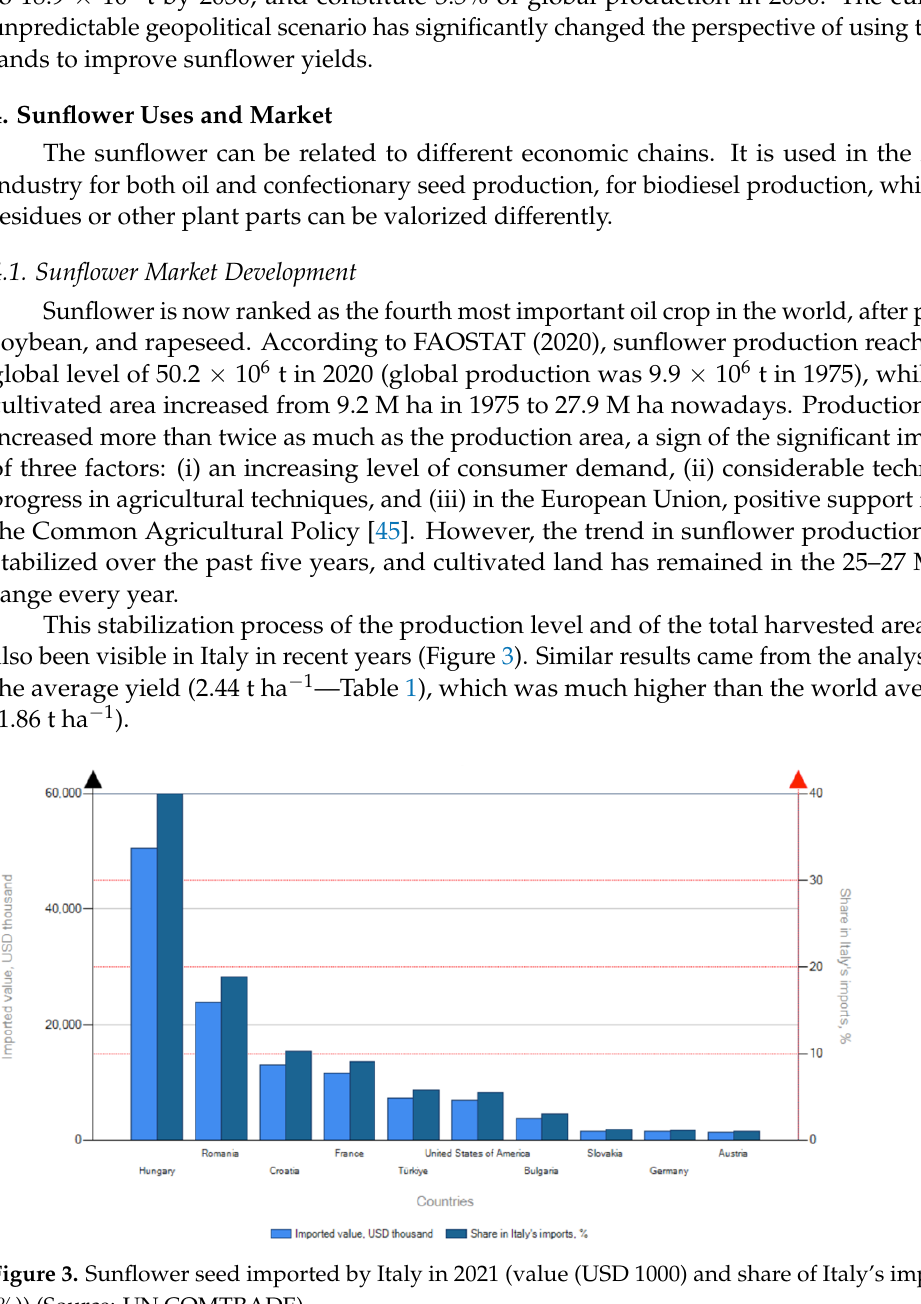
Figure 3. Sunflower seed imported by Italy in 2021 (value (USD 1000) and share of Italy’s imports, (%)) (Source: UN (%)) (Source: UN COMTRADE).